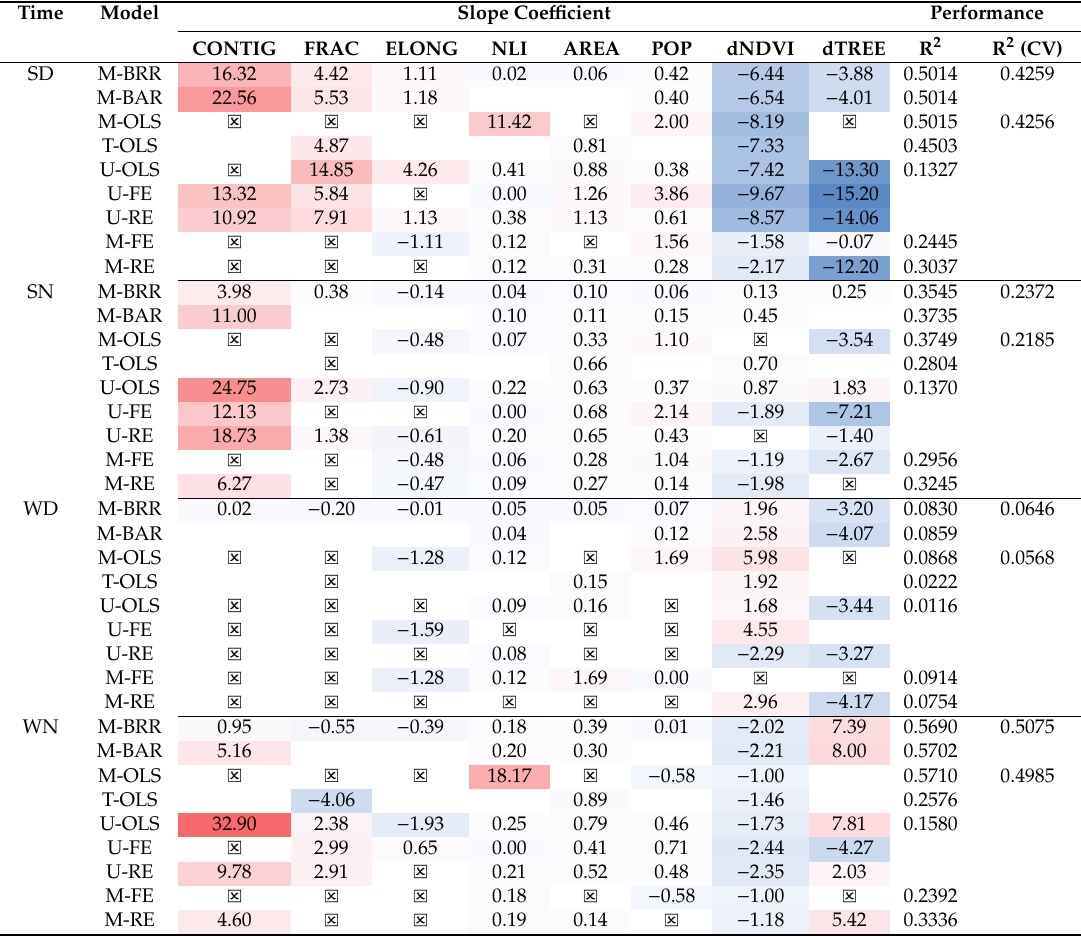
Table 1. Regression coe ffi cients and fitness of the